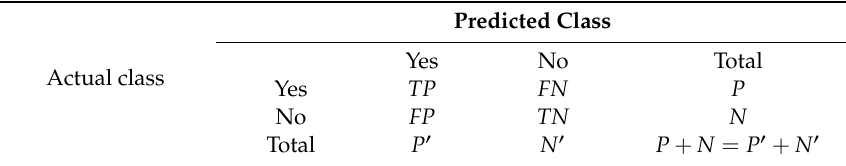
Table 1. Definition table of performance evaluation